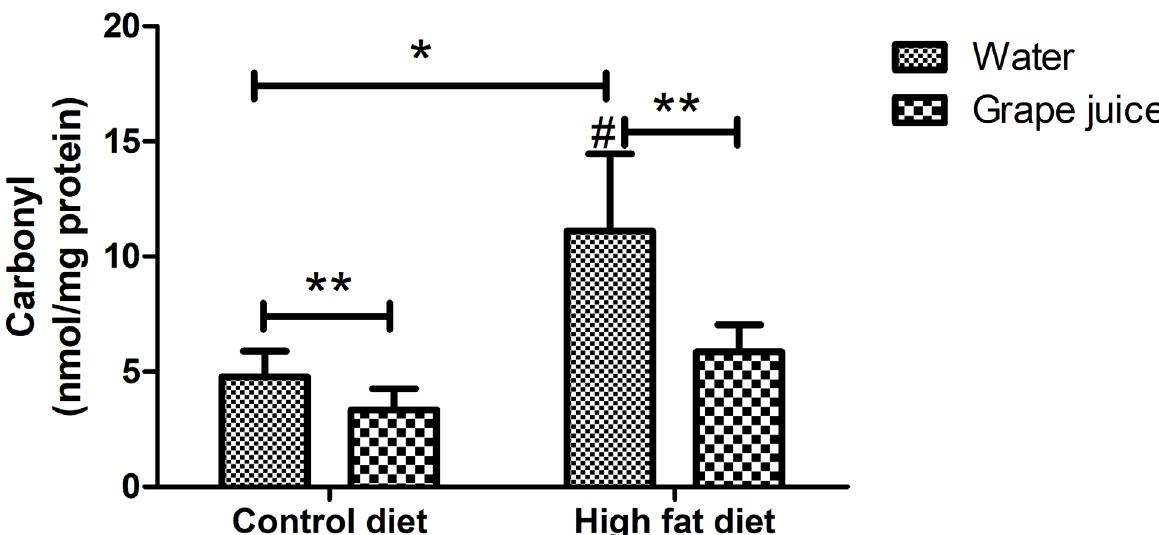
Figure 2. Carbonyl levels (nmol / mg protein), expressed as mean ± standard error of the mean in female pups hippocampus of Wistar rats treated with purple grape juice during the gestational period. * Difference between diets in groups that received water. ** Difference between groups in relation to drink factor. # factors Interaction, higher value in the group that received hyperlipidic diet and water. Statistical difference according to two-way ANOVA, followed by Tukey test, p